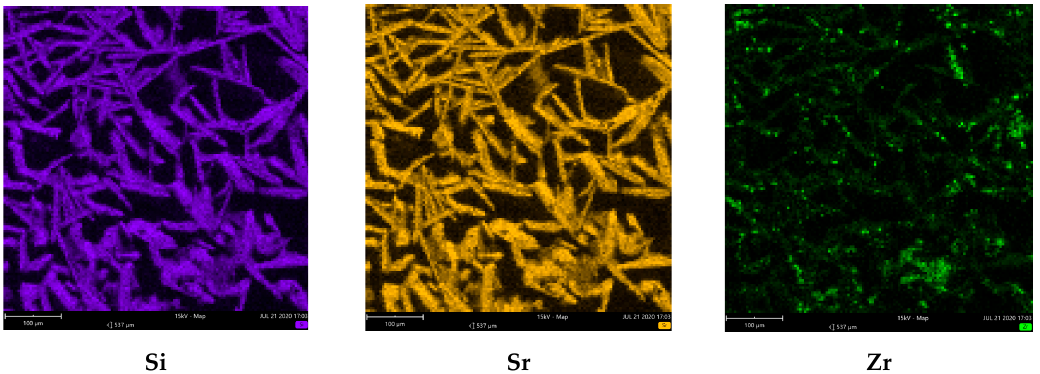
Figure 3. Element maps corresponding to Figure 1d–surface. Scale bar 100 µm.